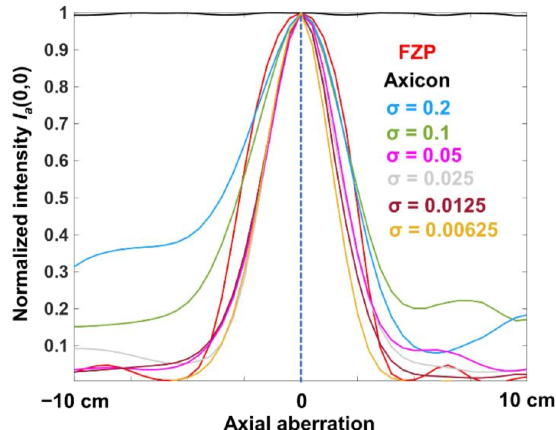
Figure 4. Plot of I a (0,0) with respect to Δ z for FZP, axicon and optical modulator with σ = 0.2, 0.1, 0.05, 0.025, 0.0125, and 0.00625. 0.05, 0.025, 0.0125, and